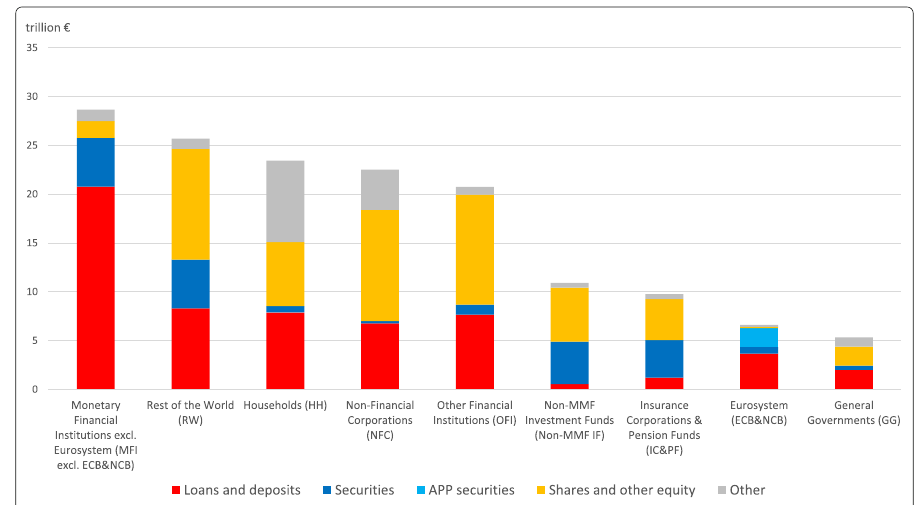
Fig. 3 Breakdown of the euro area institutional sectors’ and rest of the world’s financial assets by instrument type; June 2017. Breakdown of the euro area institutional sectors’ financial assets by instrument type, i.e., short-term and long-term loans and deposits (in red), short-term and long-term private and public debt securities (in blue), APP securities (in light blue), listed, unlisted, and investment fund shares and other equity (in yellow), and other financial assets (in grey). The residual category “other” includes i) monetary gold and Special Drawing Rights (SDRs) (totally held by Monetary Financial Institutions), ii) insurance and pension schemes (mostly, i.e., the 93.86%, held by Households), and iii) other accounts receivable and financial derivatives (mostly, i.e., the 50.66%, held by Non-Financial Corporations). Data source: (European Central Bank 2017b)